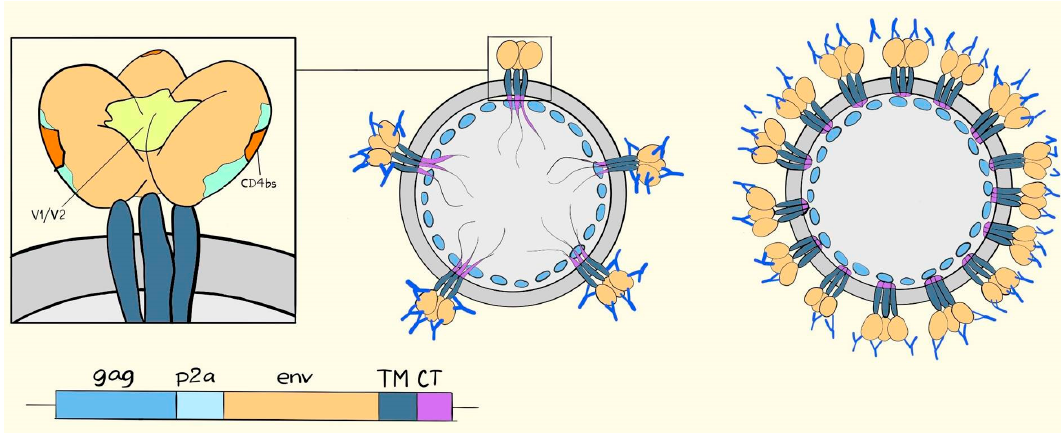
Figure 4. Drawing of the HIV Env trimer and its potential accessibility on VLPs. In the left drawing, Env is depicted with gp120 in light brown and the visible parts of gp41 containing the transmembrane region in dark blue. In the middle drawing, VLPs, scarcely coated with Env, can be seen to be approachable from all angles. Dense coating of the VLPs, as depicted in the right drawing, makes gp120 more accessible relative to gp41.